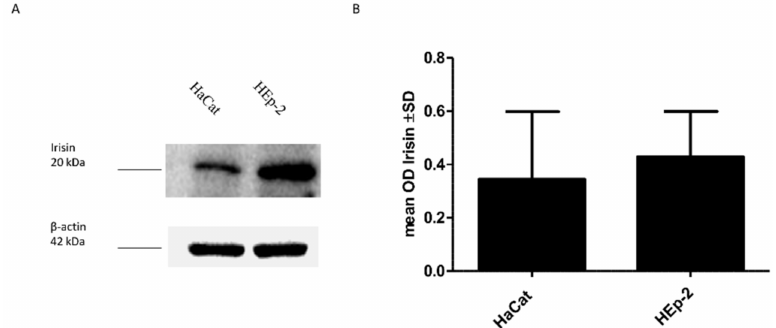
Figure 5. Comparison of irisin expression levels detected by Western blot in Normal Human Ker- atinocytes (HaCat) and Larynx Epidermoid Carcinoma 2 (HEp-2) ( A ). The mean value of the densito- metric optical analysis of the 3 repeats of Western blot detecting irisin expression levels ( B ).